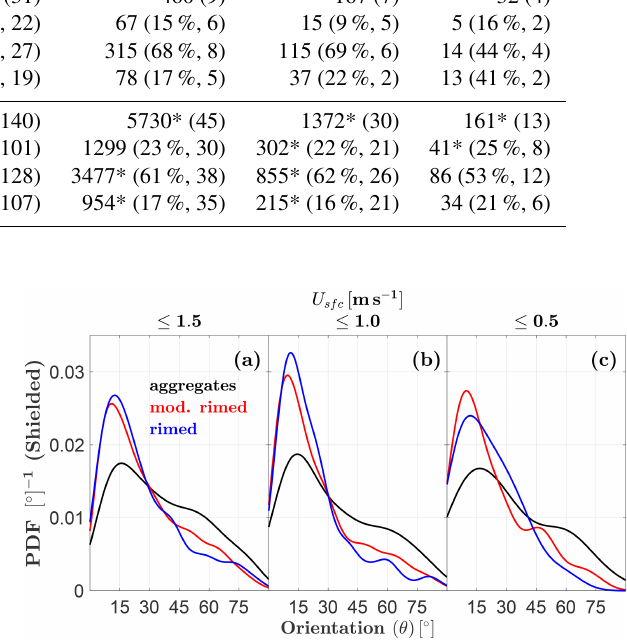
Figure 8. As in Fig. 7 but with lighter winds and hydrometeors divided into three riming degree categories: sparsely rimed aggre- gates, moderately rimed, and rimed. Only shielded MASC measure- ments are